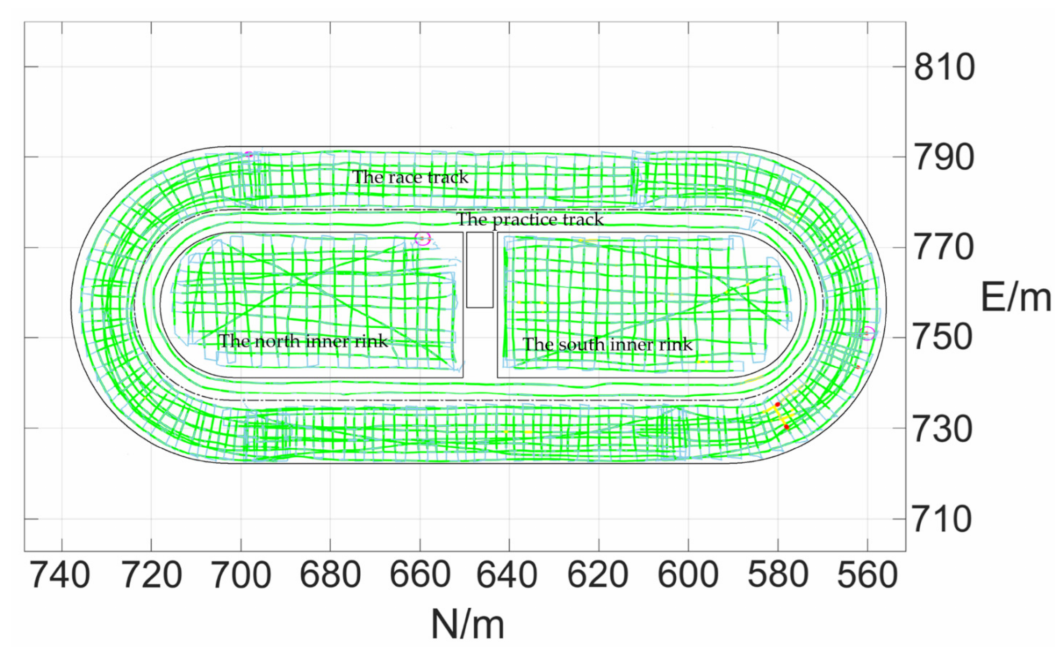
Figure 11. Overview of the measurement route of the National Speed Skating Oval.